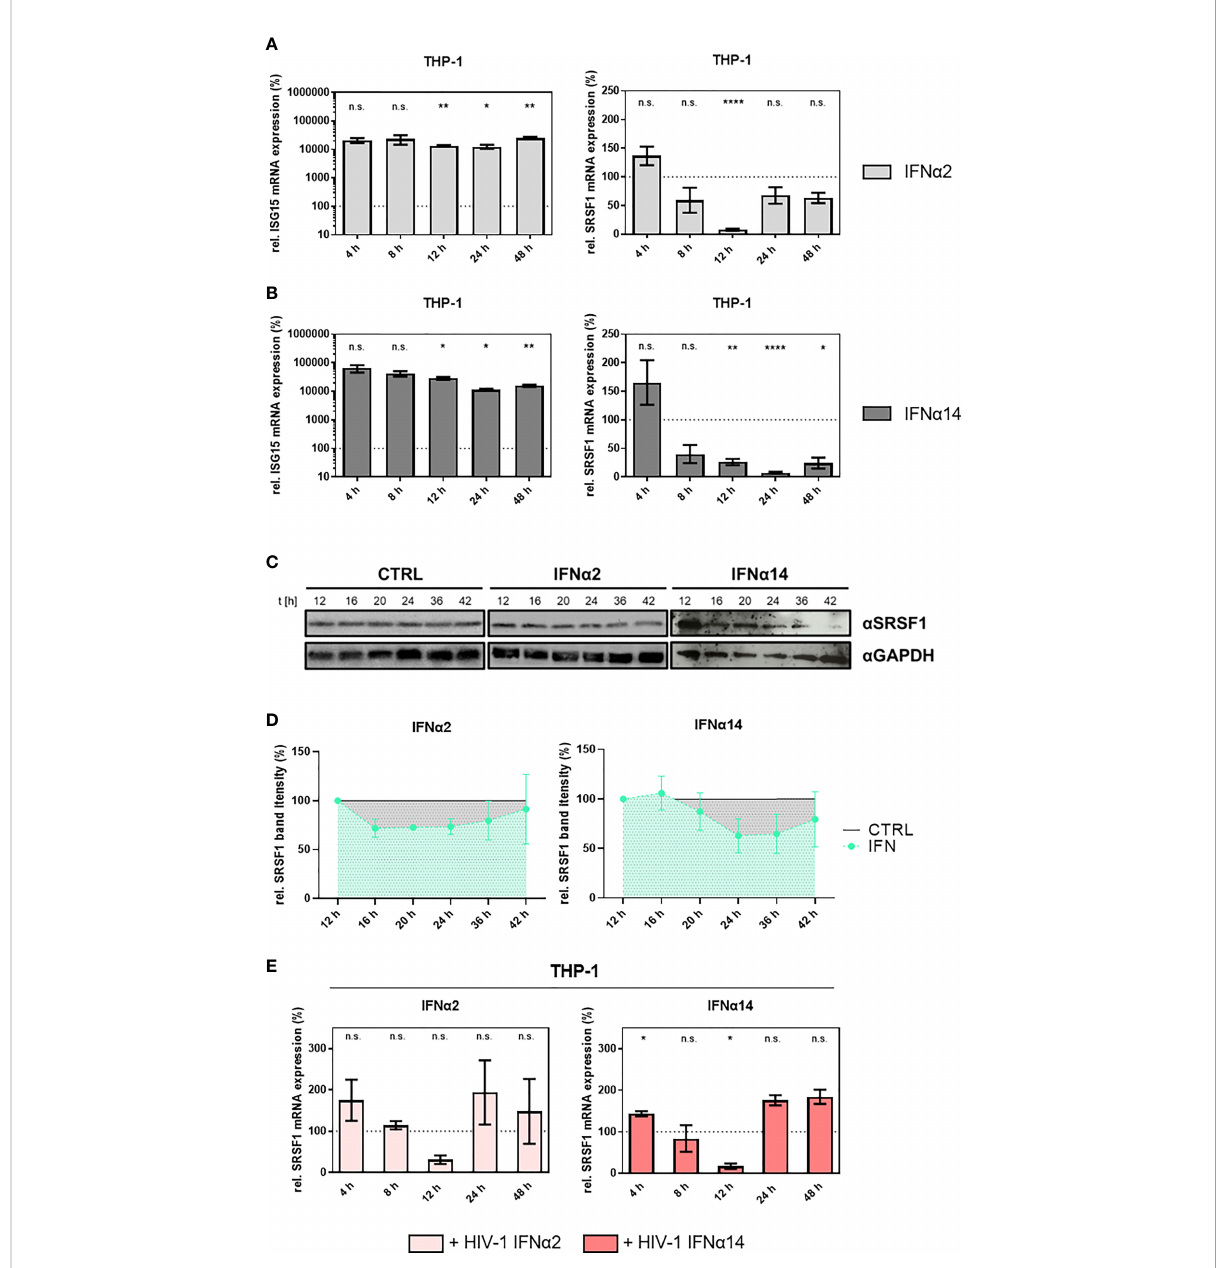
FIGURE 4 SRSF1 mRNA and protein levels are differentially regulated upon stimulation of macrophages with IFN a 2 or IFN a 14. Differentiated THP-1 macrophages were treated with IFN a 2 (light gray) or IFN a 14 (dark gray) (10 ng/ml) over a period of 48 h before cells were harvested and RNA was isolated. Relative mRNA expression levels were measured via RT-qPCR analysis. (A, B) Relative mRNA expression levels of ISG15 and SRSF1 upon stimulation with (A) IFN a 2 or (B) IFN a 14 in THP-1 cells. Mixed-effects analyses followed by Dunnett ’ s post-hoc test were used to compare differences between groups at different time points (* p < 0.05, ** p < 0.01, **** p < 0.0001 and ns, not signi fi cant). (C) Differentiated THP-1 macrophages were treated with IFN a 2 or IFN a 14 (10 ng/ml) for the indicated amount of time before cells were harvested and proteins were isolated. Proteins were separated by SDS-PAGE, blotted, and analyzed with an antibody speci fi c to SRSF1. A representative Western blot is shown using GAPDH as a loading control. (D) Quanti fi cation of multiple Western blots ( n = 4 for IFNa14, n = 3 for IFNa2). Total protein amount was stained using Trichloroethanol and used as loading control. Band intensity was measured using ImageJ software. Mixed-effects analyses followed by Dunnett ’ s post-hoc test. (E) Differentiated THP-1 macrophages were infected with the R5-tropic NL4-3 (AD8) (95) at an MOI of 1. Sixteen hours post-infection, cells were treated with the indicated IFN subtype (10 ng/ml) over a period of 48 h. Cells were harvested at the indicated time points, and RNA was isolated and subjected to RT-qPCR. Relative mRNA expression levels of SRSF1 in THP-1 cells after treatment with IFN a 2 or IFN a 14 as indicated. GAPDH was used as a house-keeping gene for normalization. Mixed-effects analyses followed by Dunnett ’ s post-hoc test were used to determine whether the difference between the group of samples reached the level of statistical signi fi cance (* p < 0.05, ** p < 0.01, *** p < 0.001 and **** p < 0.0001). Mean ( ± SEM) of n = 4 biological replicates is